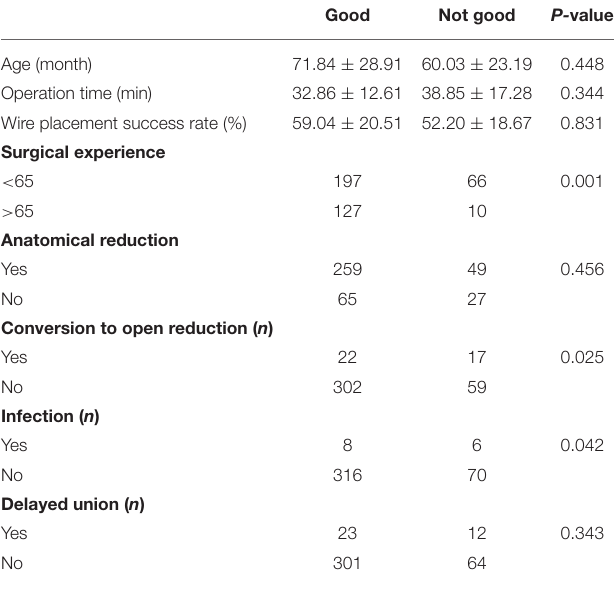
TABLE 6 | Multivariate logistic regression analysis of post-operative functional recovery in eligible